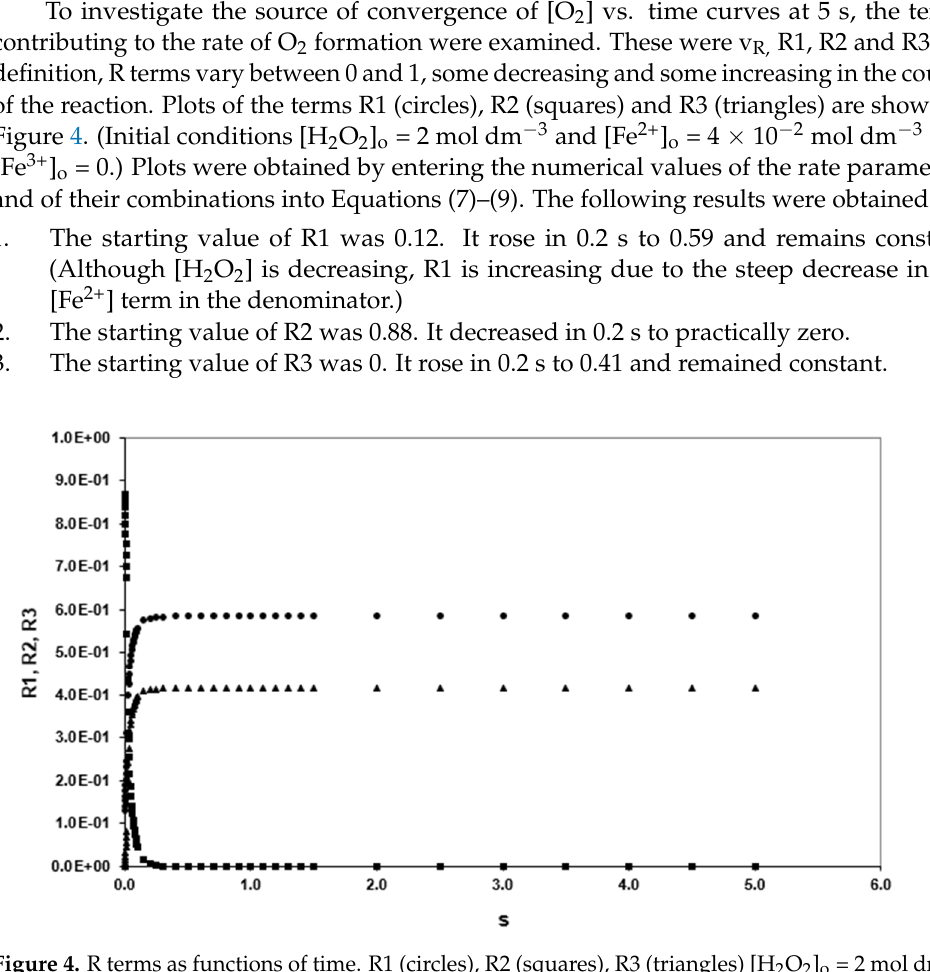
Other parameters as in Figure 2.